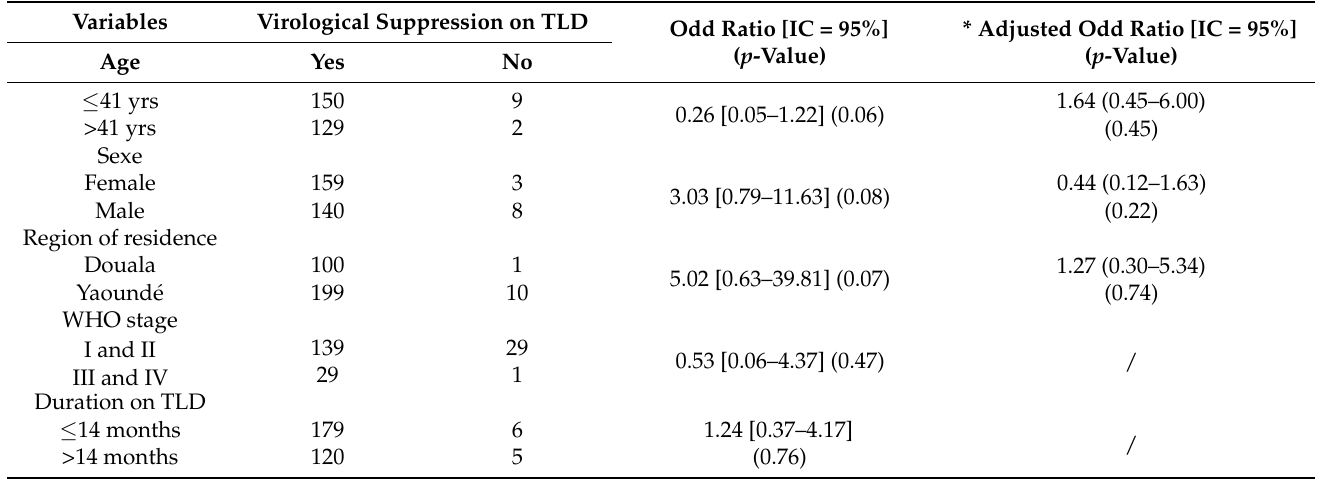
Table 2. Evaluation of sociodemographic factors potentially associated with virological suppres- sion in Cameroonian individuals treated with tenofovir + lamivudine + dolutegravir (TLD).